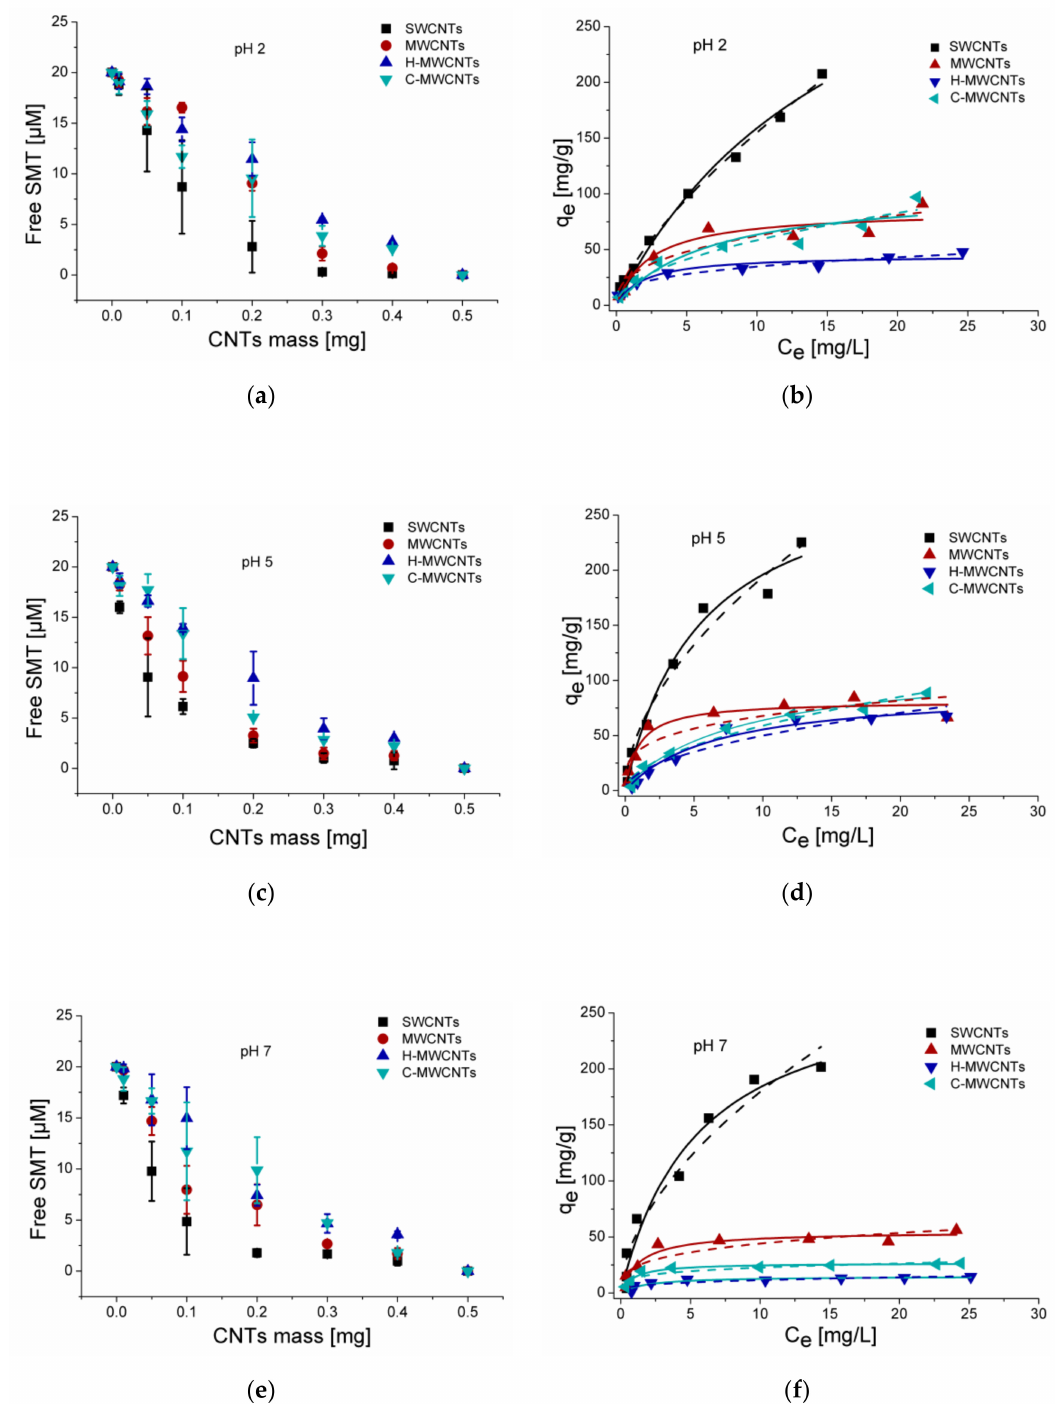
Figure 1. Removal of SMT from the aqueous solution using SWCNTs, MWCNTs, H-MWCNTs, or C-MWCNTs. E ff ect of increasing amount of carbon nanotubes (CNTs) (0.00, 0.01, 0.05, 0.10, 0.20, 0.30, 0.40, and 0.50 mg / 1.5 mL) on the SMT (initial concentration 20 µ M) content of a phosphate bu ff er ( a ) at pH 2 ( c ) 5, and ( e ) 7. Langmuir (solid line) and Freundlich (dashed line) isotherms for the SMT adsorption onto CNTs in a phosphate bu ff er ( b ) at pH 2 ( d ) 5, and ( f )